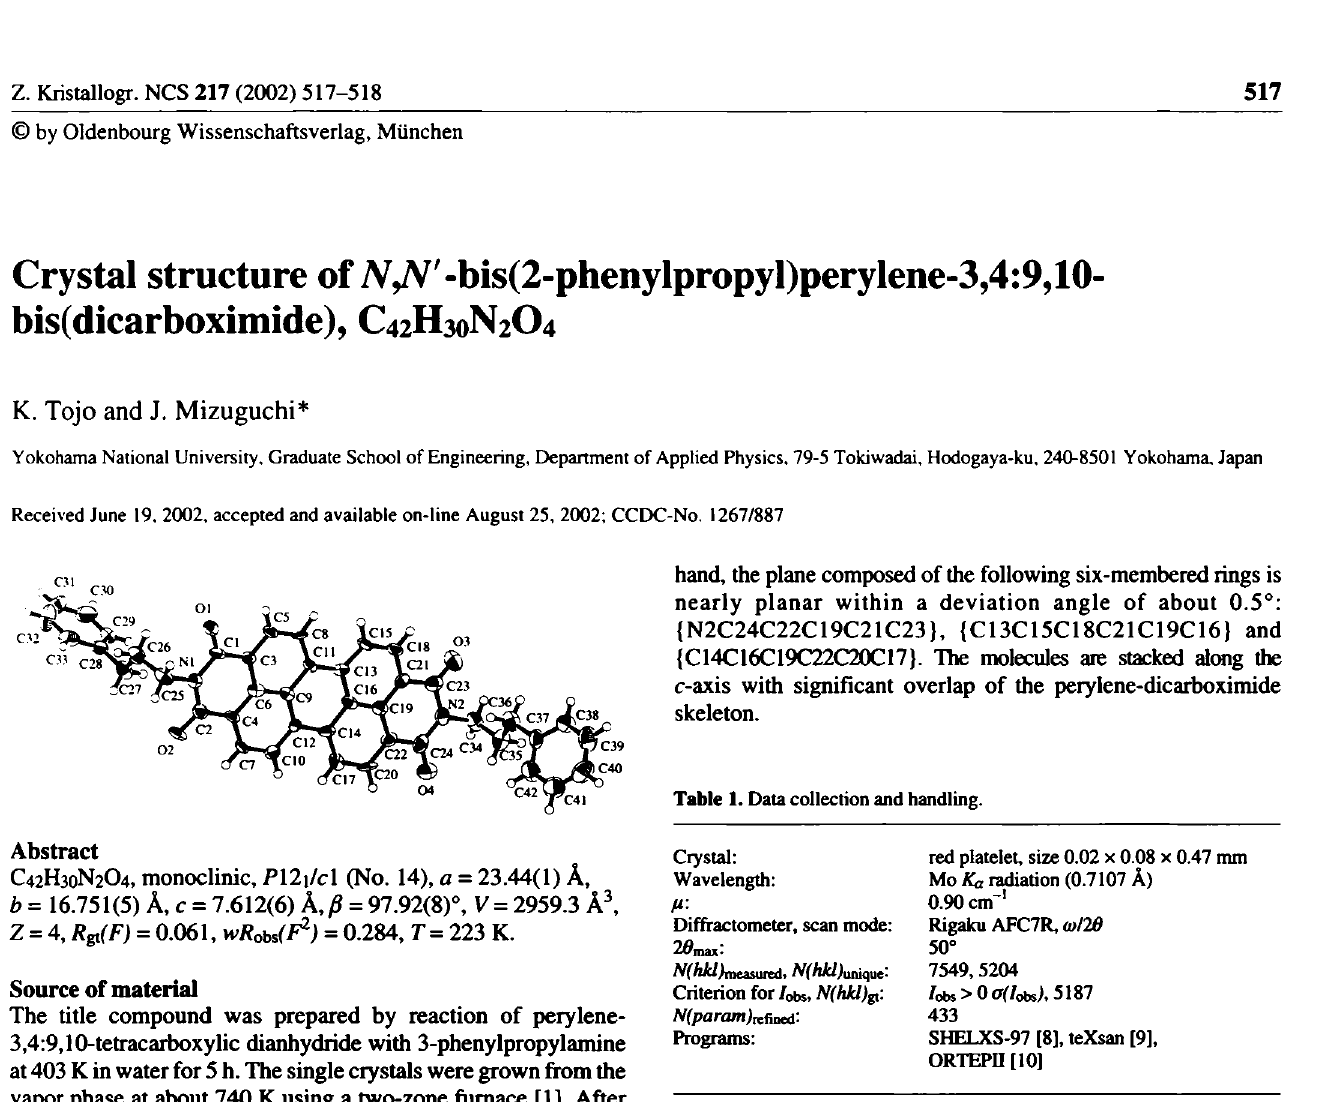
Table 2. Atomic coordinates and displacement parameters (in Â 2